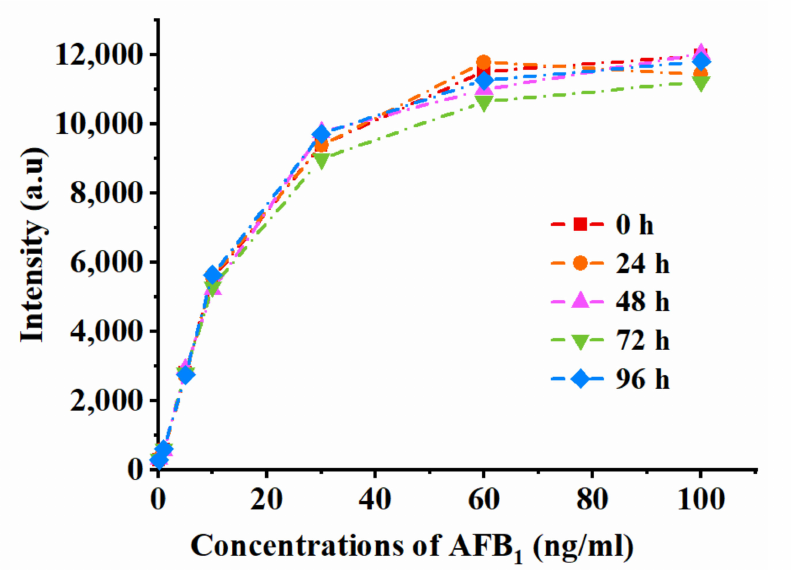
Figure 4. Trend plots of the response values of the Apt-strip to different concentrations of AFB 1 with a 24 h